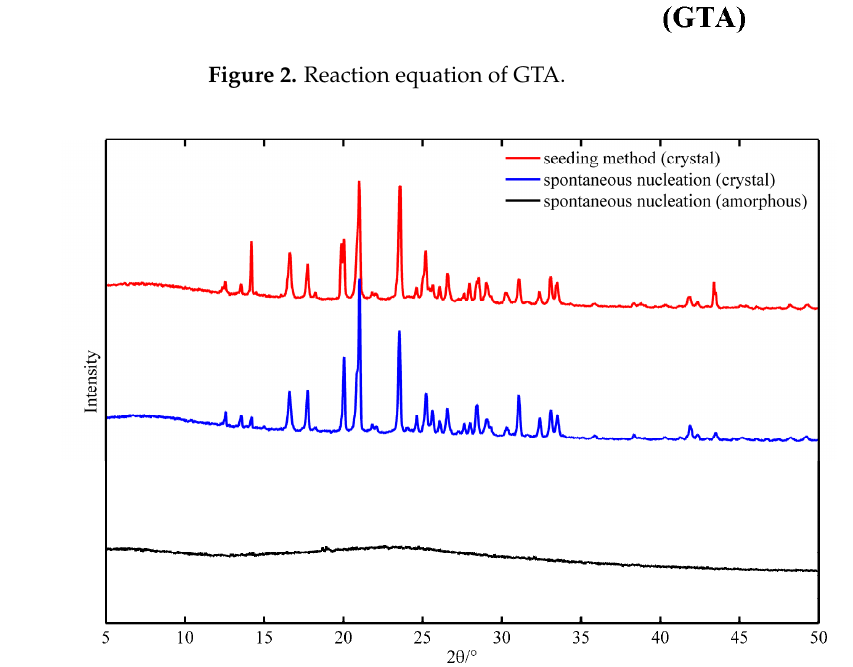
Figure 3. XRPD patterns of GTA product prepared by different methods.